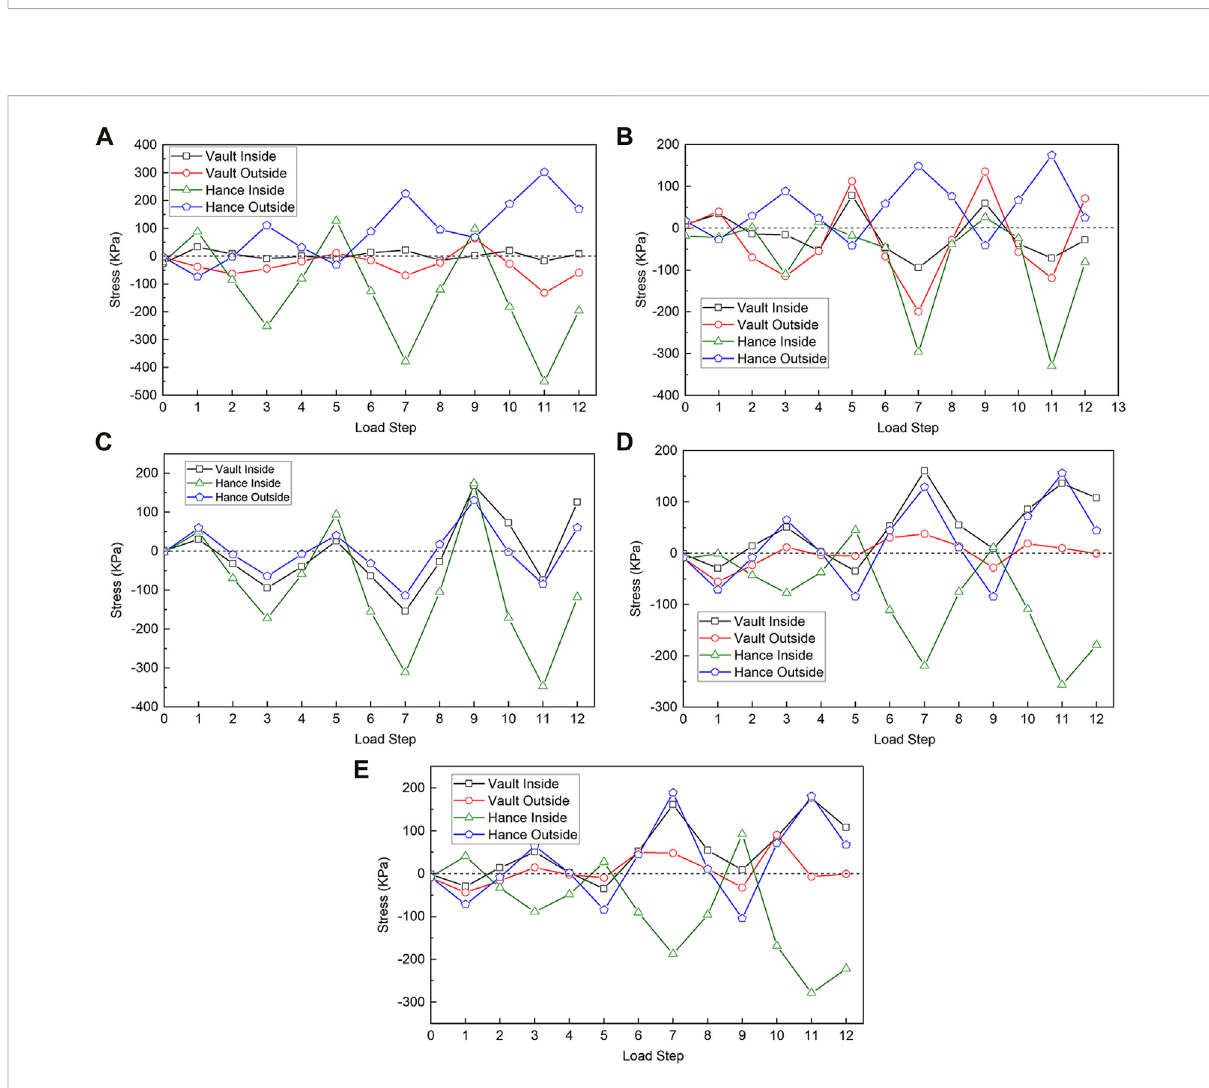
FIGURE 11 Load-Stress curves at key points in the lining (A) no arrangement, (B) arragement in the arch waist and side wall, (C) arragement in the vault, (D) standard arrangement, (E) sparsely arrangement.